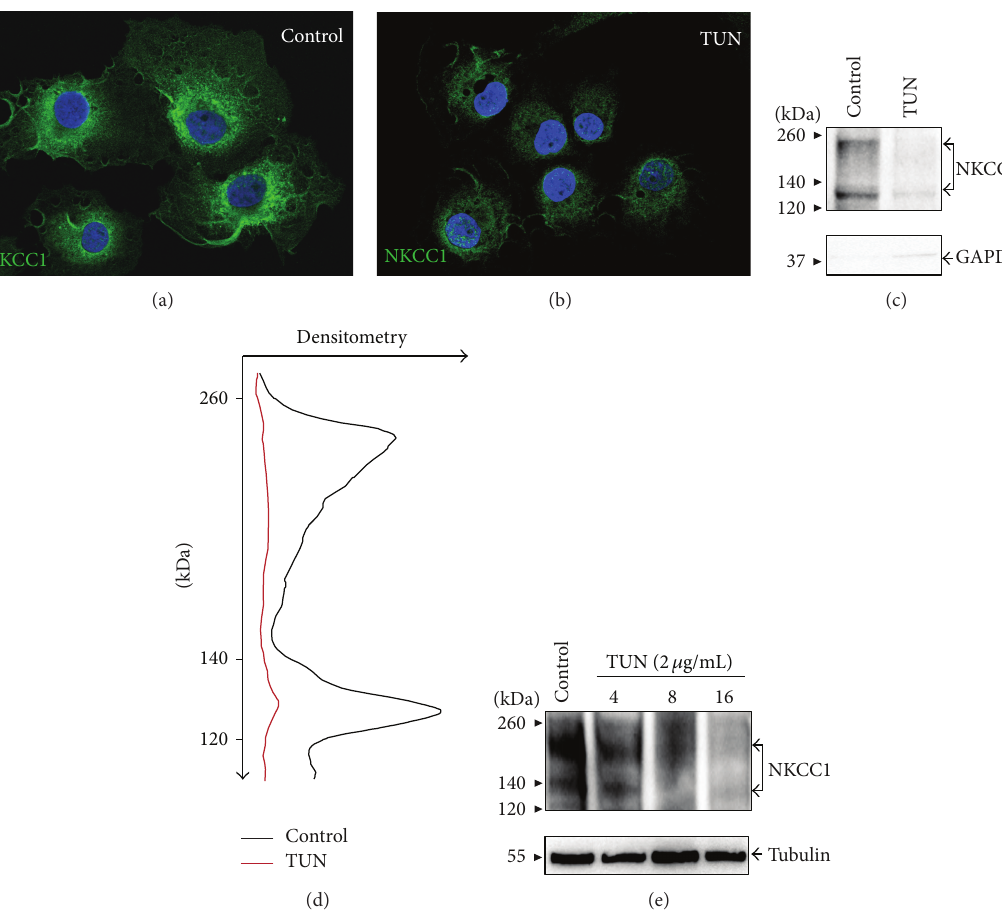
Figure 8: The first step of N-glycan biosynthesis is required for NKCC1 protein expression. ((a)-(b)) Shown are representative immunofluorescence microscopy images of COS7 cells grown under control conditions (a) or treated for 16h with 2 𝜇 g/mL tunicamycin (TUN, (b)). NKCC1 immunolocalization was analyzed with T4 and FITC-labeled secondary antibodies (green). (c) Representative immunoblot with ckNKCC1 demonstrating expression of NKCC1 in the biotinylated plasma membrane fraction purified from COS7 cells controlortreatedwithTUN.ProteinexpressionofcytosolicGAPDHwasusedtoassessthepurityofbiotinylatedplasmamembranefractions. (d) Densitometry scanning of the immunoblot in (c) representing the extent to which TUN (red trace) decreases plasma membrane located NKCC1 (black trace). (e) Representative immunoblot showing the expression pattern of total NKCC1 in COS7 cells in response to TUN 2 𝜇 g/mL during the indicated periods of time. As loading control, immunoblots were probed against